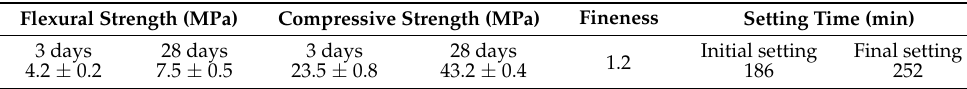
Table 1. Mechanical properties of Portland cement (MPa).